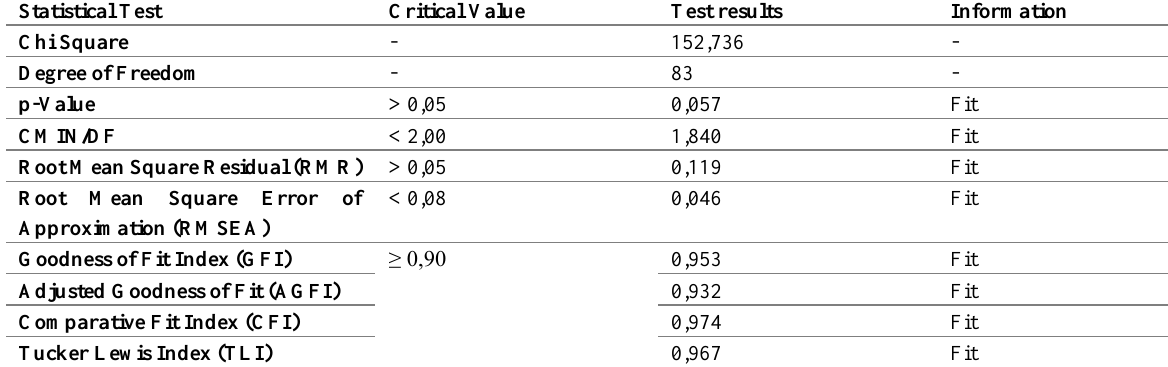
Figure 3 : Alternative Model Table 6: Model Fit in Alternative Models After